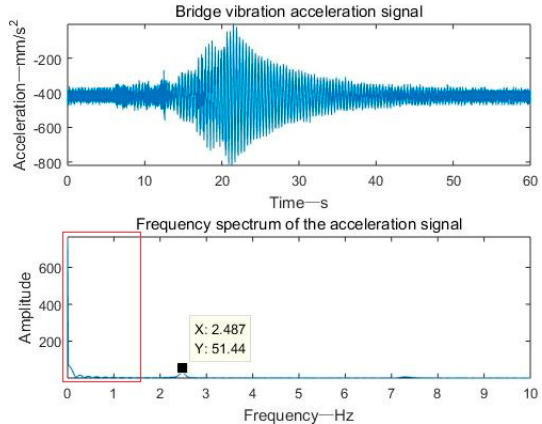
Figure 17. Bridge vibration acceleration signal and frequency domain spectrum.